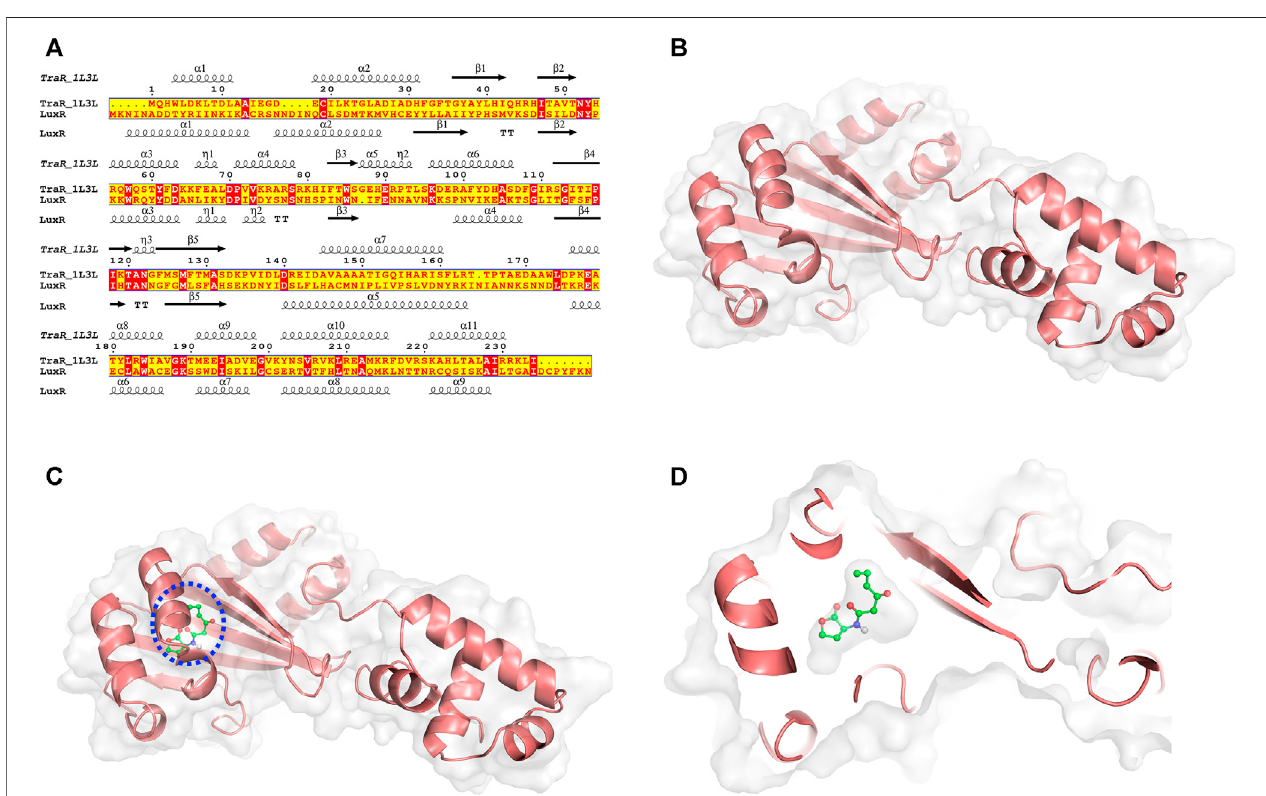
FIGURE 1 | MD simulations and structural conformations of the V. fi scheri LuxR. (A) Sequence alignment of Agrobacterium tumefaciens TraR (PDB ID: 1L3L) and Vibrio fi scheri LuxR (DDBJ accession no. AF170104). Conserved amino acid residues are shown in red. (B) Overall modelled structure of V. fi scheri LuxR. (C) Overall conformation and (D) close-up view of the LuxR – 3OC6-HSL composite structure. The protein is displayed as a cartoon, and 3OC6-HSL is displayed using stick